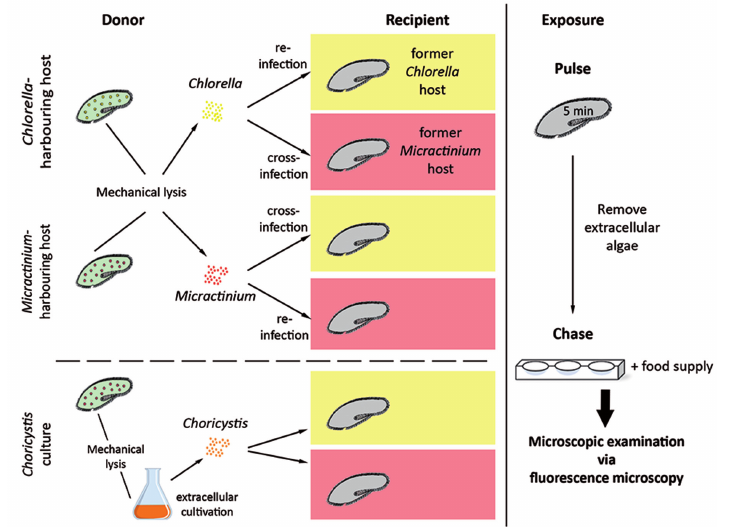
Figure 1. Pulse-chase infection experiments to assess the symbiosis specificity between Paramecium bursaria and its symbiotic algae. Symbiotic cultures of P. bursaria (donor) were mechanically lysed